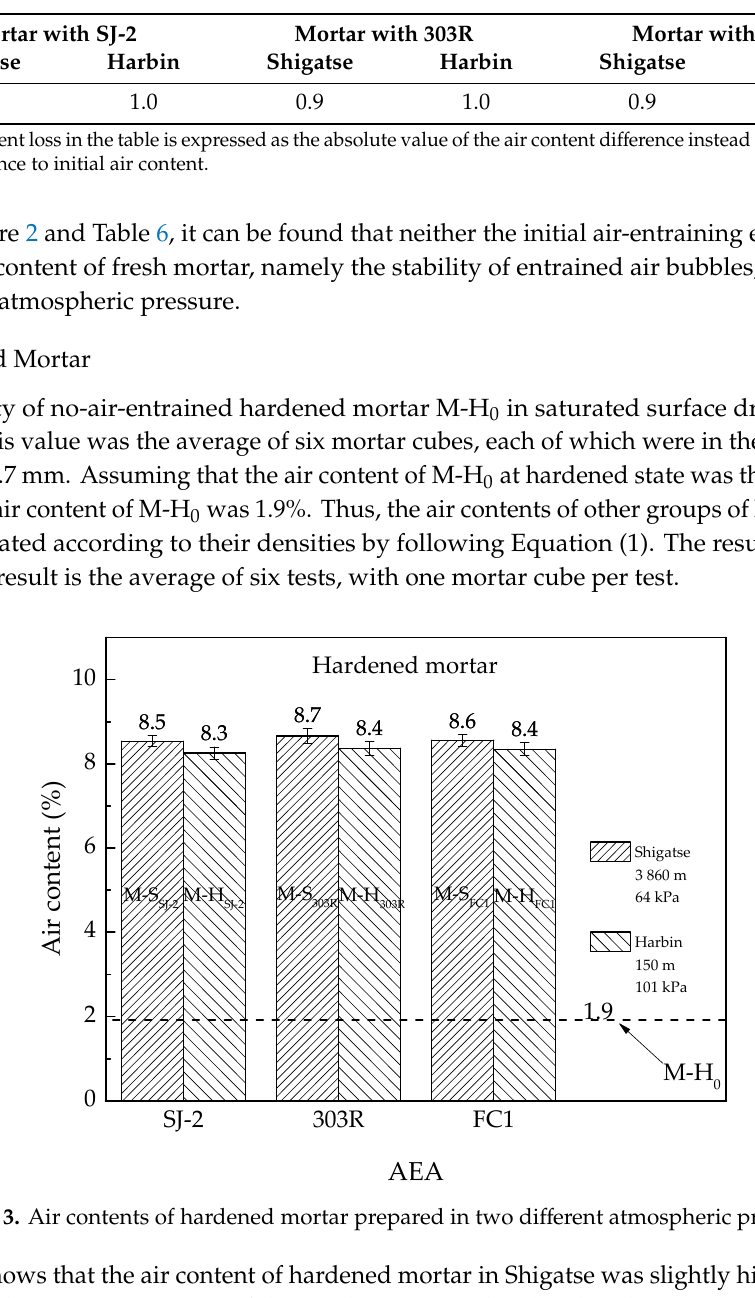
Figure 3. Air contents of hardened mortar prepared in two different atmospheric pressures.